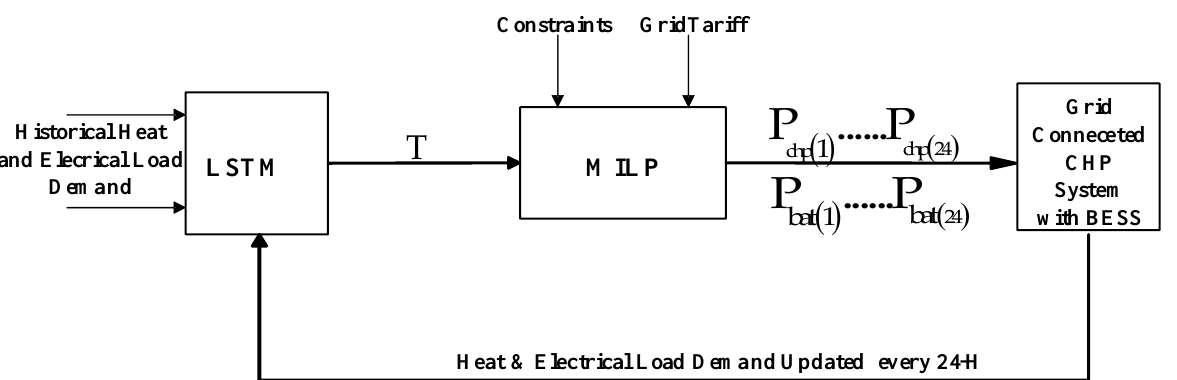
Figure 3. LSTM-MILP flow model for real-time operation of the grid-connected CHP system (offline optimisation scheme).